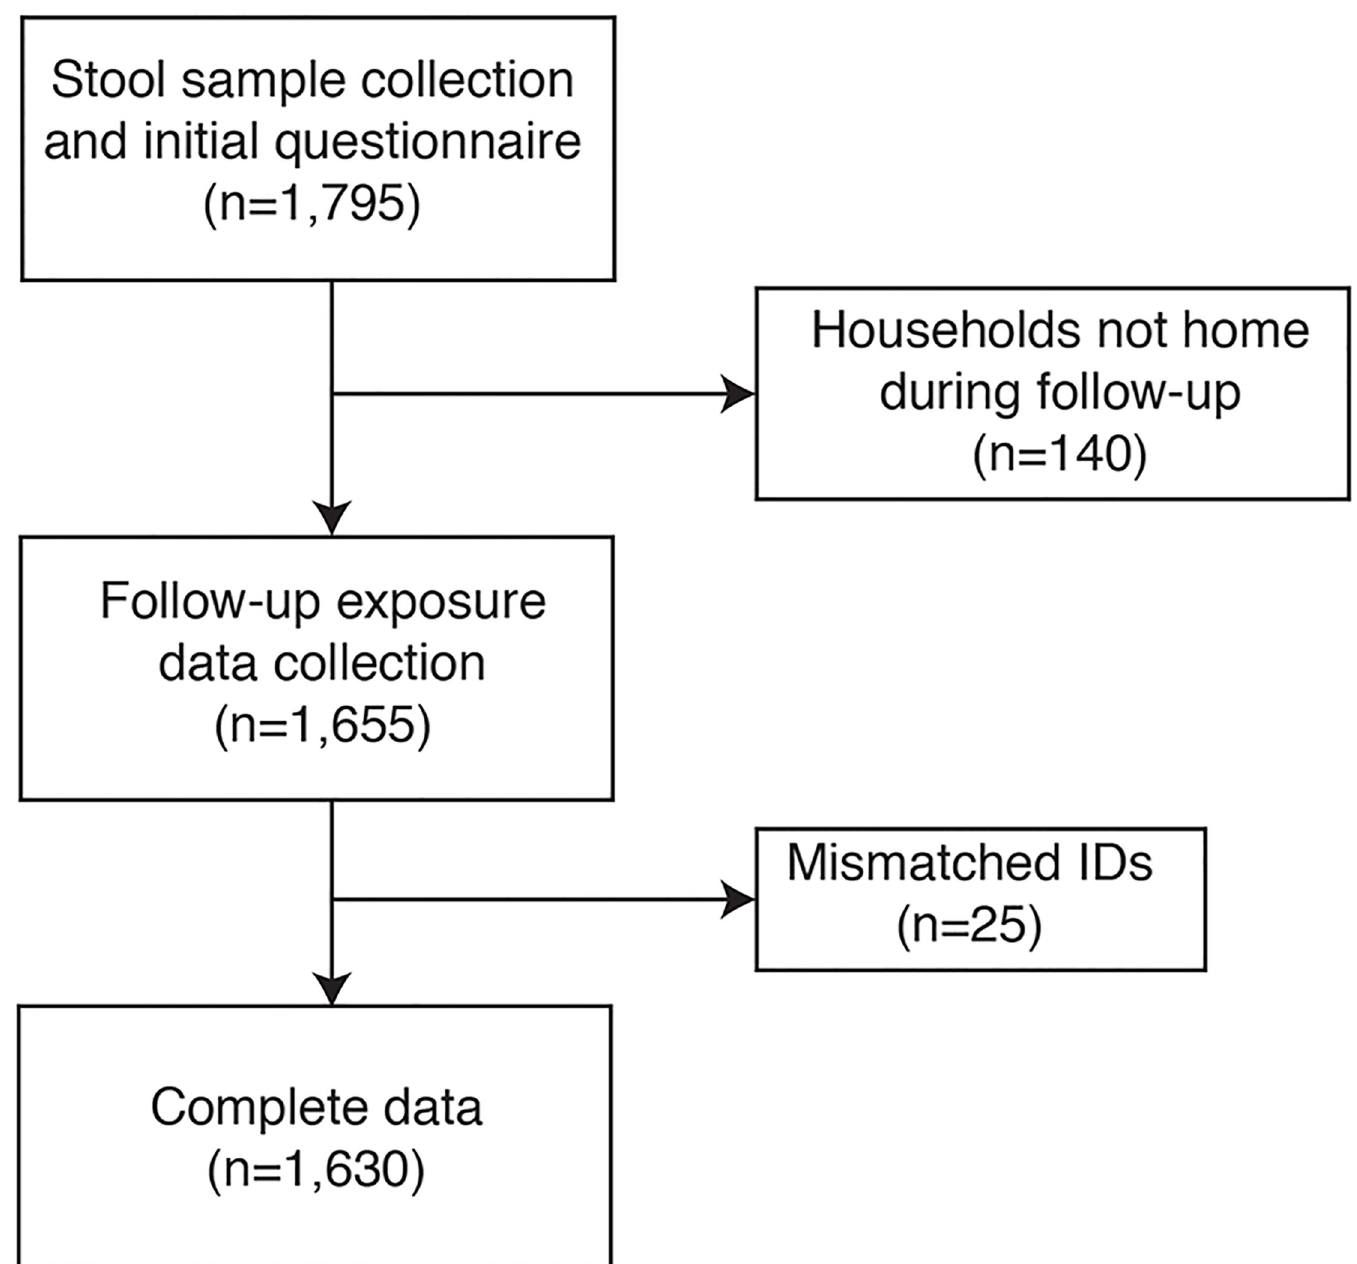
Fig 1. Data collected. This figure shows the number of surveys returned, samples analyzed, and final sample size for this